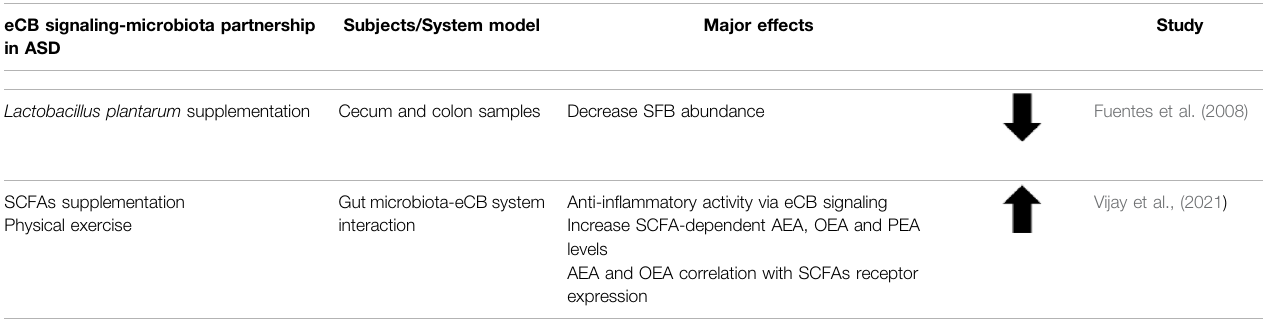
TABLE 2 | ( Continued ) Summary table of the key studies involving eCB signaling and gut microbiota crosstalk in both patients with ASD and ASD-like animal